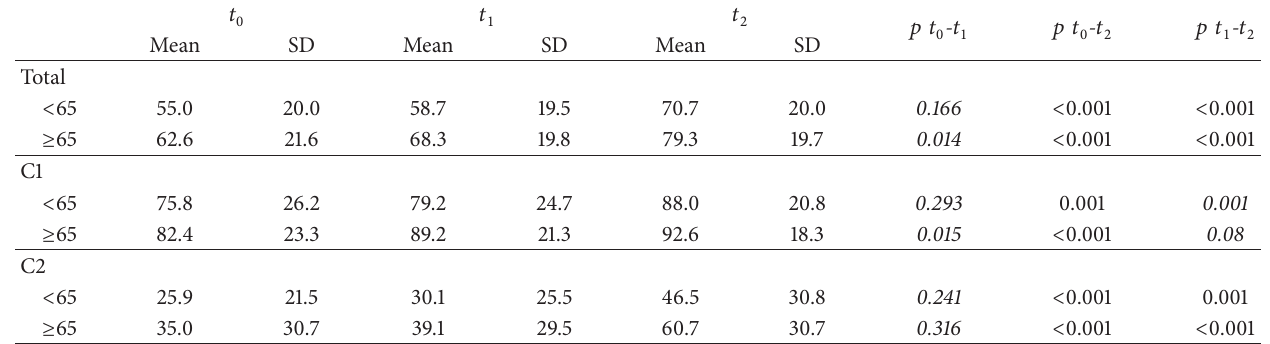
Table 4: Scale results, segmented by age ( 𝑛 = 88